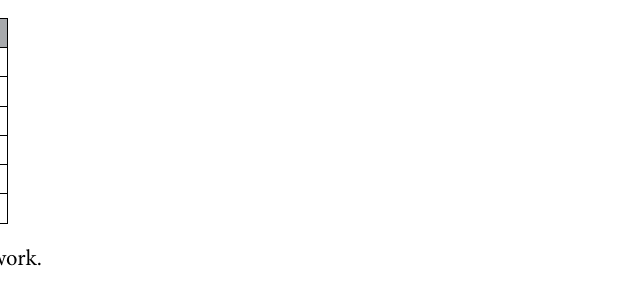
overlapping targets were performed relying on Metascape platform according to the P < 0.01. There were 818, 26, and 66 GO terms related to biological processes, cell components, and molecular functions, respectively (Fig. 6). Inflammatory response, collagen metabolic process, and leukocyte migration was the significantly enriched for BP. For Membrane raft, extracellular matrix, and side of membrane was the significantly enriched for CC. Oxi-